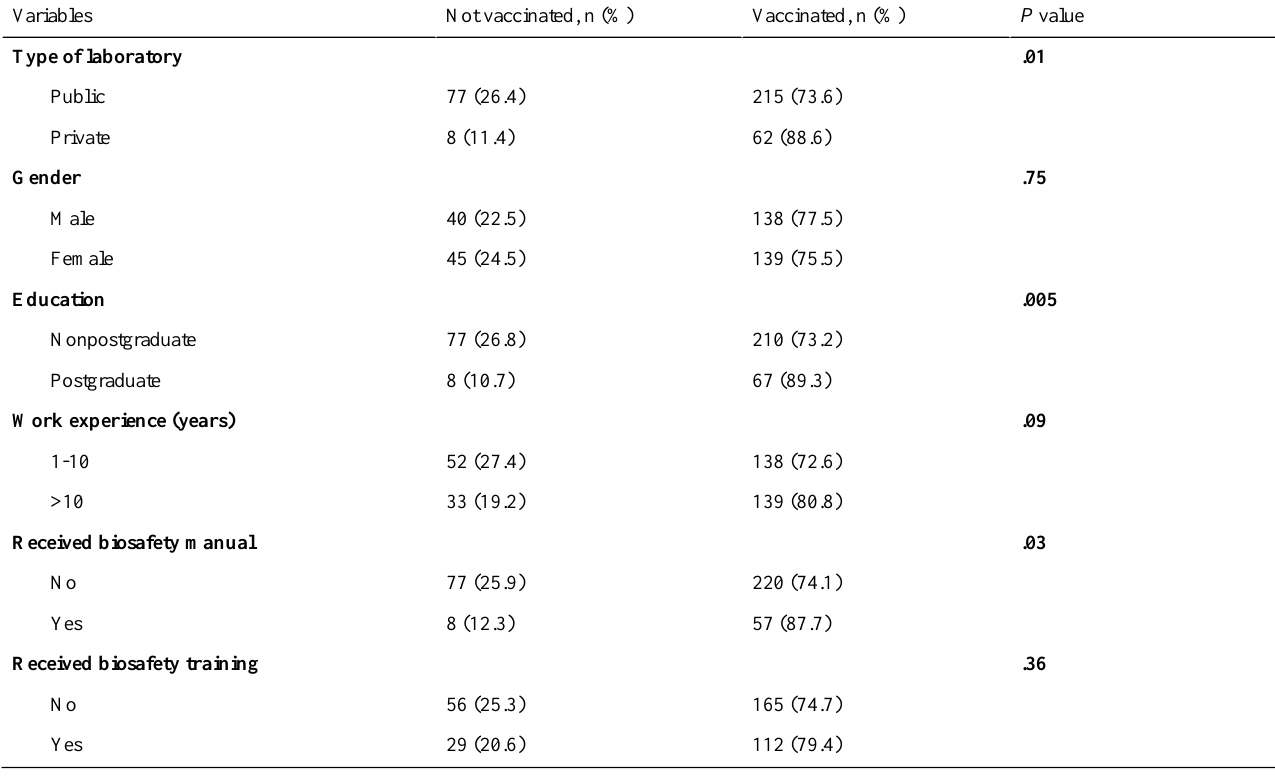
Table 4. Hepatitis B virus vaccination status and associated factors